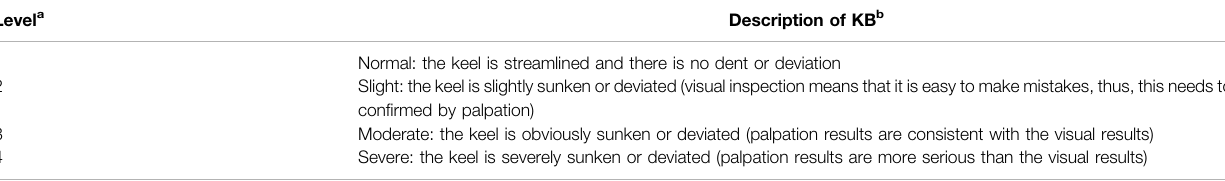
TABLE 1 | Classi fi cation of KB severity in White Leghorn chickens. Level a Description of KB b Normal: the keel is streamlined and there is no dent or deviation 2